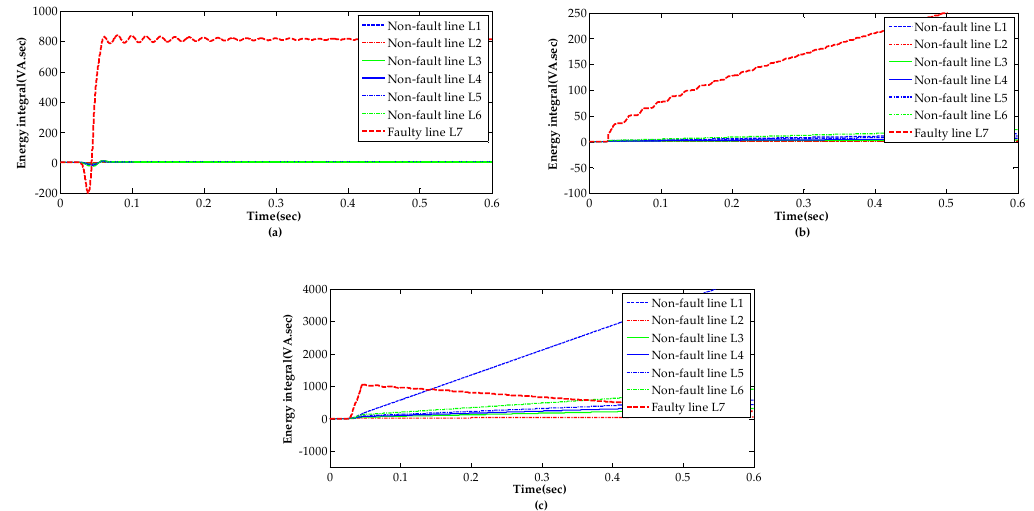
Figure 14. Comparison of the three energy integral under a SPG fault occurring on the line L 1 , at 2 km away from the bus, at 0° initial phase angle, with a resistance of 200 Ω . ( a ) The results of the energy integral scheme in this paper; ( b ) the results of the energy integral scheme in [20]; ( c ) the results of the energy integral scheme in [21].